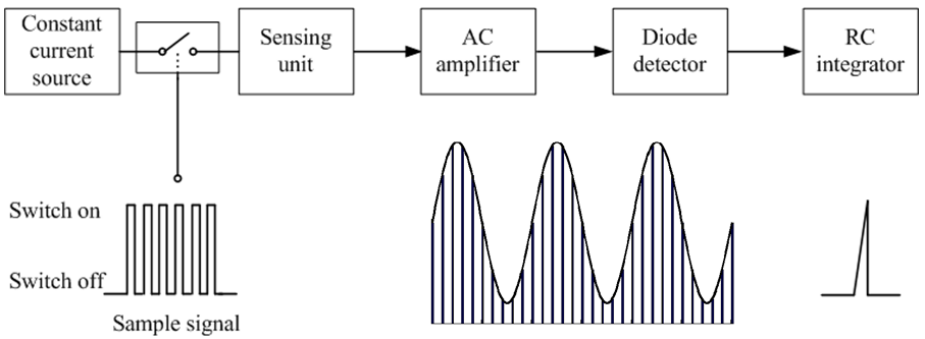
Figure 1. Block diagram of how PAM works in the RIP module.